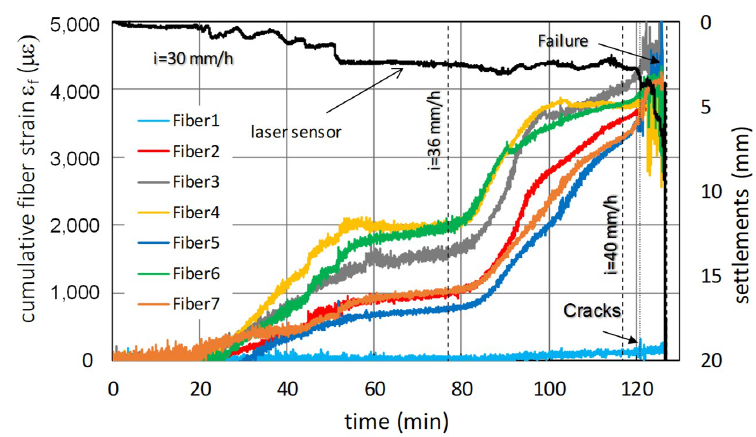
Figure 12. Cumulated strain evolution measured by the seven transversal optical fibers.